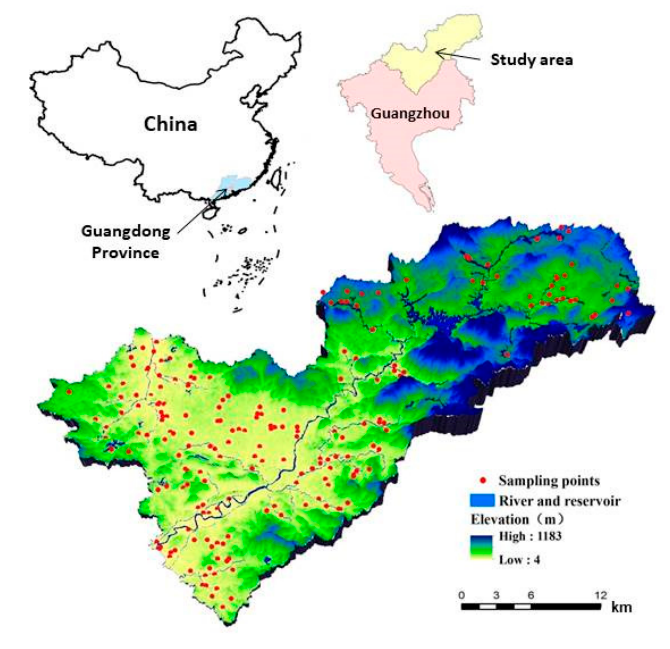
Figure 1. Location and geographical feature of the study area, Conghua of Guangzhou in China.